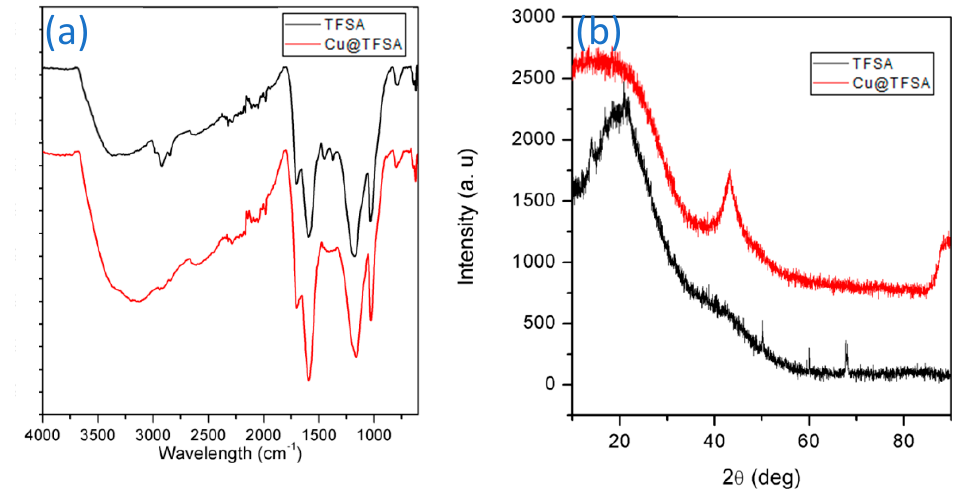
Figure 3. ( a ) ATR-FTIR spectra of TFSA before and after Cu 2+ adsorption; and ( b ) XRD patterns of TFSA before and after Cu 2+ adsorption (C 0 = 150 mg/L, 25 °C, pH = 5.5).